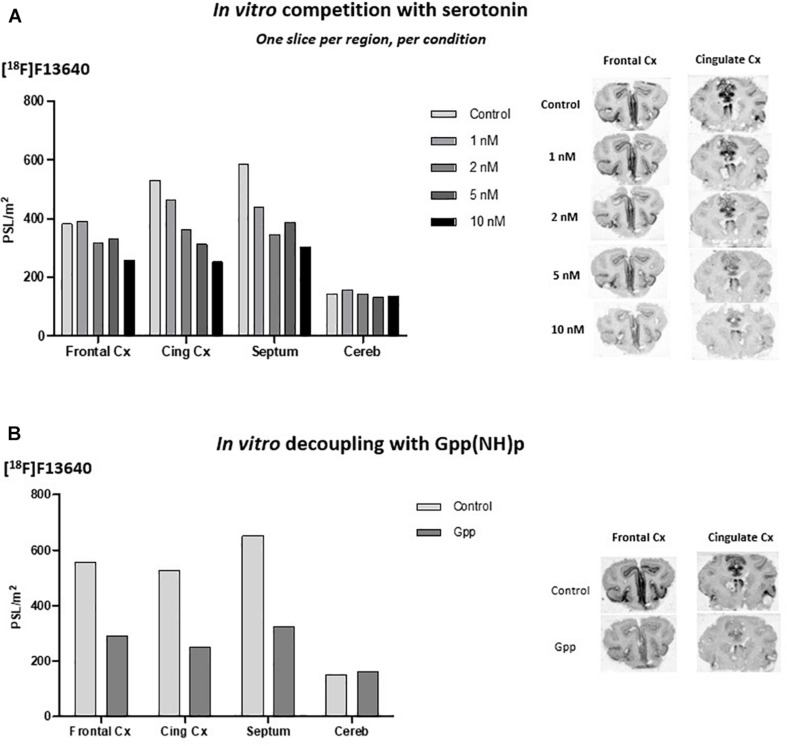
(A) [18F]F13640 in vitro binding in cat brain with increasing concentrations of serotonin (Front Cx, frontal cortex; Cing, cingulate cortex; Septum, lateral septum; Cereb, cerebellum). (B) [18F]F13640 in vitro binding in cat brain with addition of 10 μM of Gpp(NH)p (Front Cx, frontal cortex; Cing Cx, cingulate cortex; Septum, lateral septum; Cereb, cerebellum).